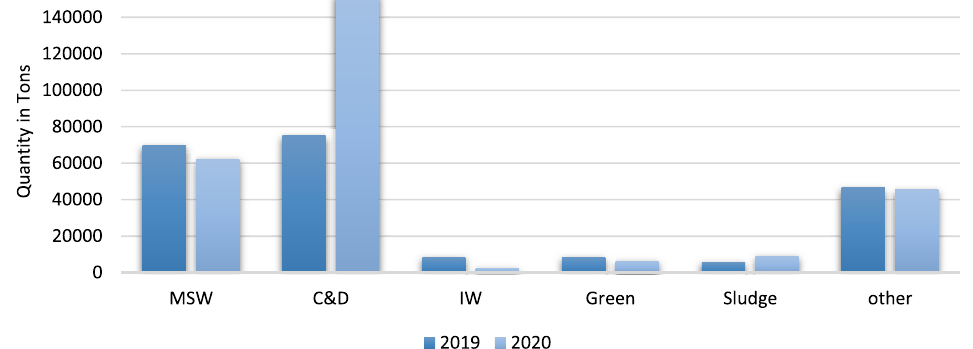
Fig. 4. Waste comparison 1st quarter (2019 – 2020) (Ajman (cid:1) UAE) [15].